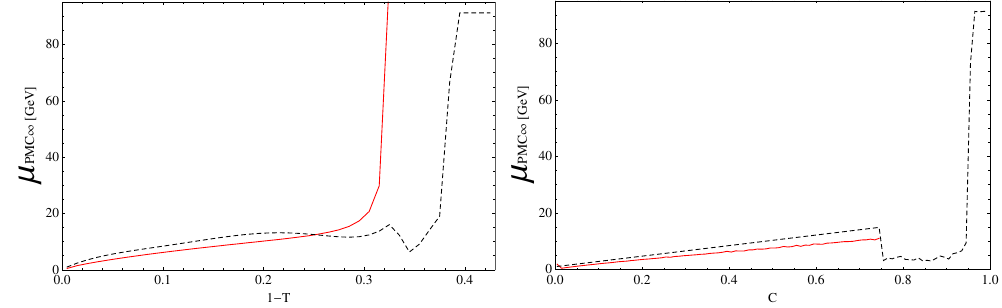
Figure 1: The LO-PMC ∞ (Solid Red) and the NLO-PMC ∞ (Dashed Black) scales for thrust (Left) and C-parameter (Right) (Ref. [ 13 ] .)